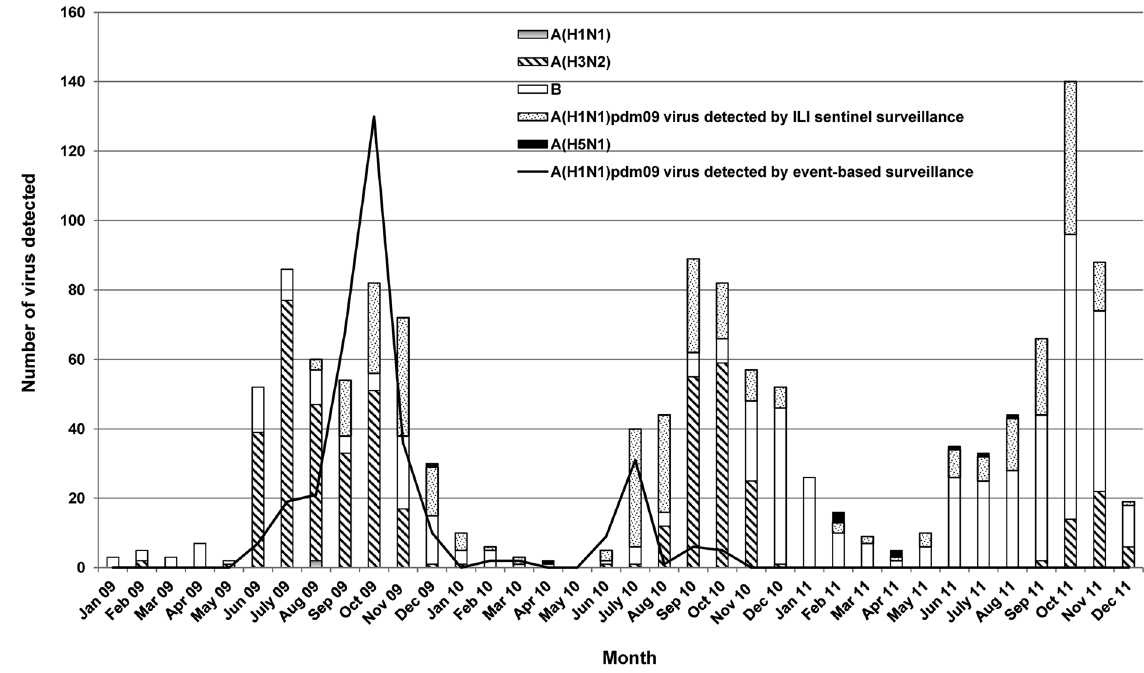
Figure 1. Monthly distribution of influenza virus detected from 2009 to 2011.